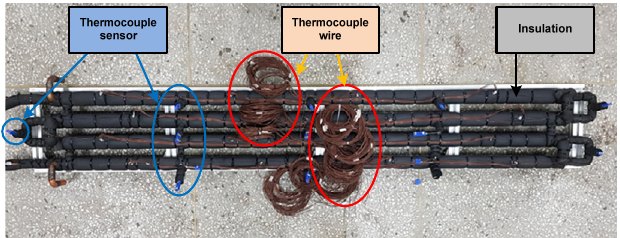
Figure 3. Photograph of the experimental apparatus for the R744 evaporation heat transfer. Table 1. Specifications of R744 evaporator.